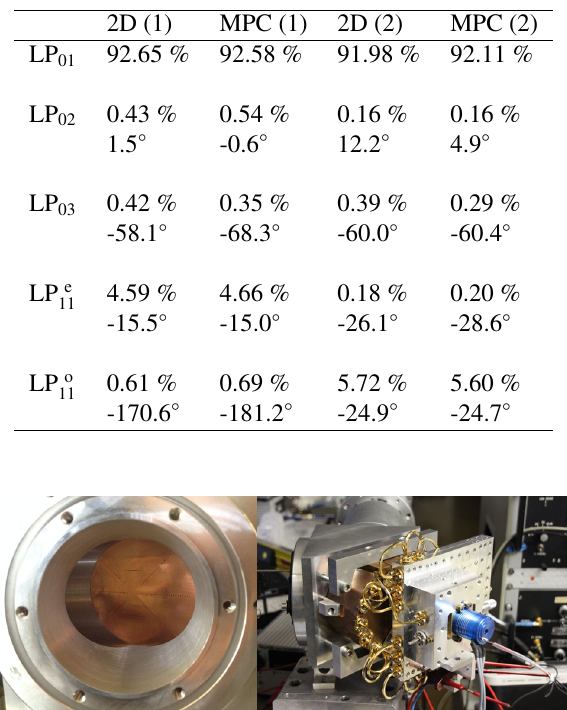
Table 1. Mode powers and phase di ff erences from 2D scan mode analysis and multiport coupler measurements (MPC) for two tested field configurations. The LP 21 modes are not shown, because their mode content is less than 0.2 %.